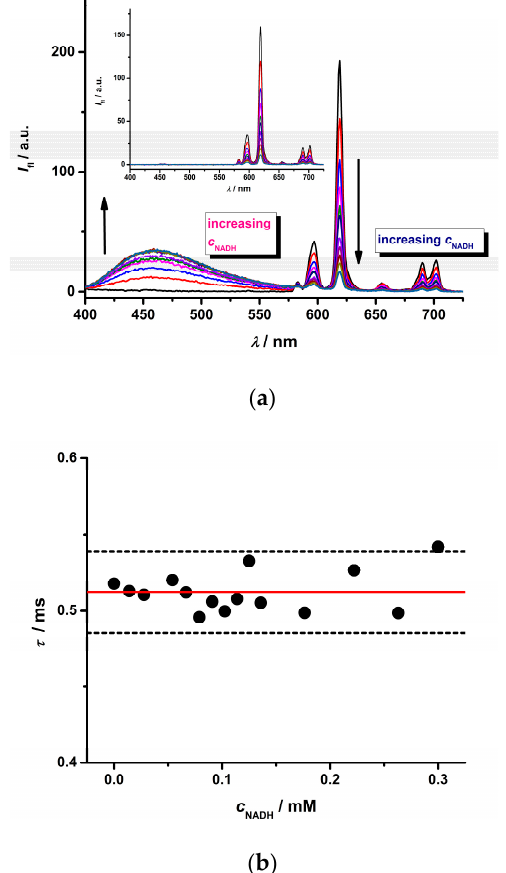
Figure 6. ( a ) Luminescence spectra of the Eu(III) ternary complex in the presence of NADH (the concentration in µ M scale: 0, 27, 50, 66, 80,92, 99, 117, 127, 133, 158) for gating time 0 and 100 ms. ( b ) The luminescence decay of the Eu(III) ternary complex measured with the increased NADH + concentration (the average value is equal to 0.512 ± 0.013 ms). The experimental conditions ( c EuL , c IQCA , pH) are the same as in Figure 7.